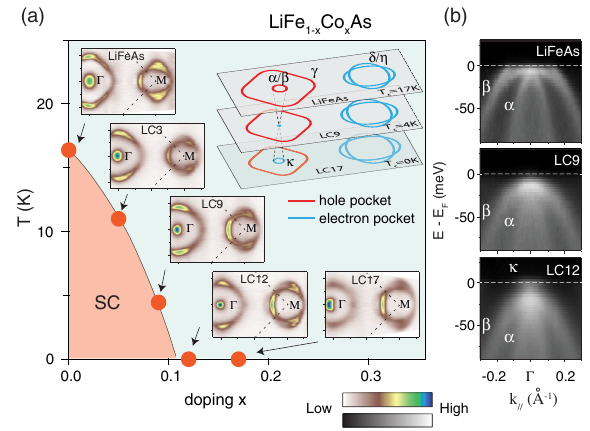
FIG. 6. (a) The phase diagram and corresponding photoemis- sion intensity maps for LiFe 1 − x Co x As. The top-right inset panel illustrates the doping dependence of the Fermi-surface topol- ogies, where the hole and electron pockets are plotted with the red and blue lines, respectively. (b) Doping dependence of the photoemission intensity distributions taken near the zone center along the Γ -M direction for LiFe 1 − x Co x